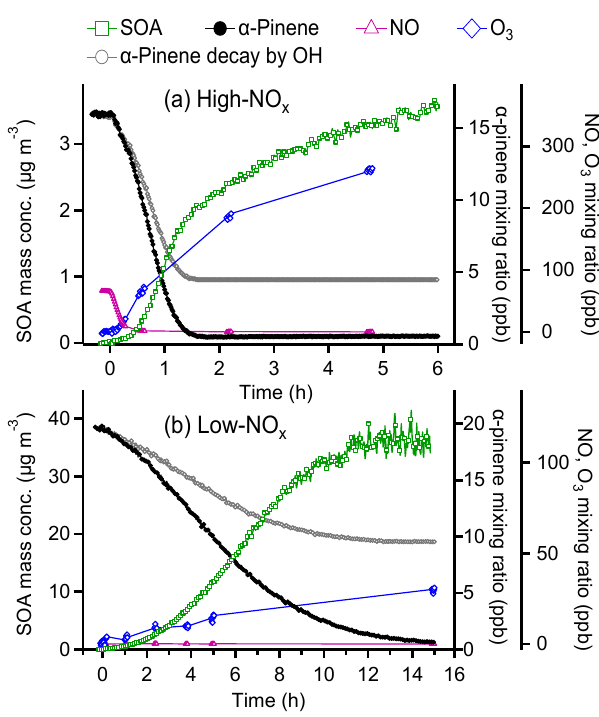
Figure 1. Time series of the mass concentrations of generated SOA and the mixing ratios of NO, O 3 , total α -pinene decay, and OH- consumed α -pinene in (a) high- and (b) low-NO x experiments us- ing ammonium sulfate as seed particles. Time = 0h is defined as α -pinene photooxidation initiated when lamps were turned on. The presented SOA mass concentrations have been corrected for particle wall loss according to the decay of sulfate